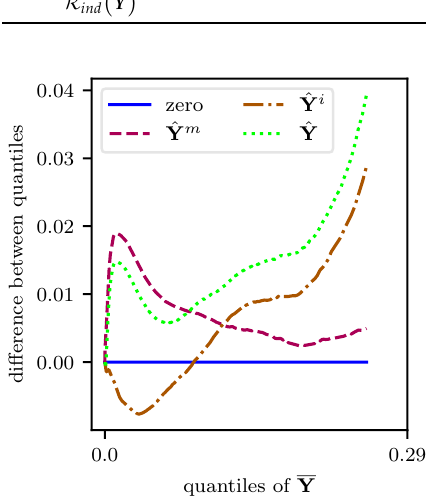
Figure 7. Quantile plot showing the effects of the metamodel uncertainty and the inherent uncertainty on the frequency distribution of the results in Monte-Carlo simulations relative to the RSM Y , neither with metamodel uncertainty nor with inherent uncertainty. The RSMs ˆ Y m , ˆ Y i and ˆ Y consider either the metamodel uncertainty, the inherent uncertainty or both, respectively.